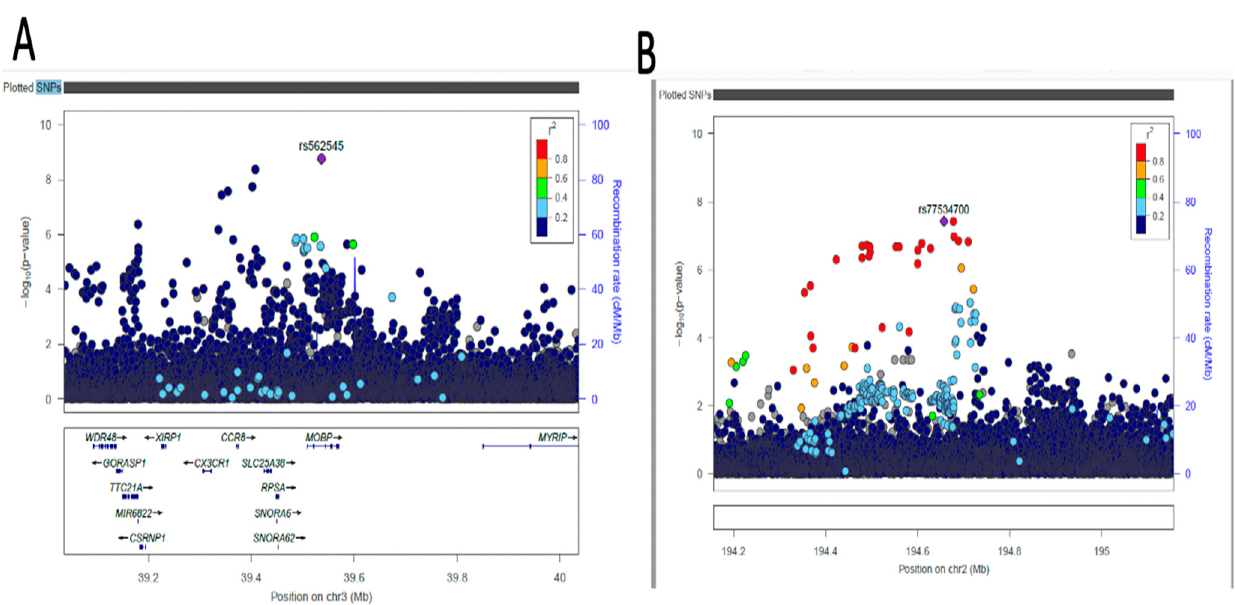
Figure 4. Regional visualization of the GWAS of − log10 of the p -value of genomic location MOBP (rs562545 in purple) ( A ) and AC074290.1 (rs77534700 in purple) ( B ), with each dot representing SNP on the corresponding genes at the bottom.